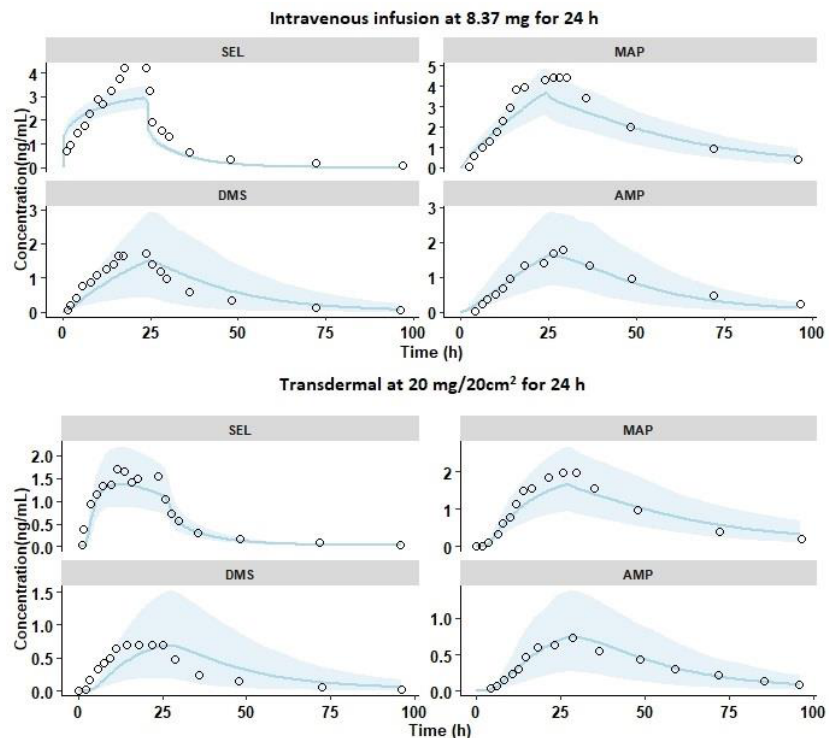
Figure 3. Overlay plots of observed and predicted mean pharmacokinetic profiles of SEL and its metabolites with 90% prediction interval represented as the shaded area (sky blue). The black open circles represent the mean observed data; the solid lines (sky blue) represent the simulated profiles.